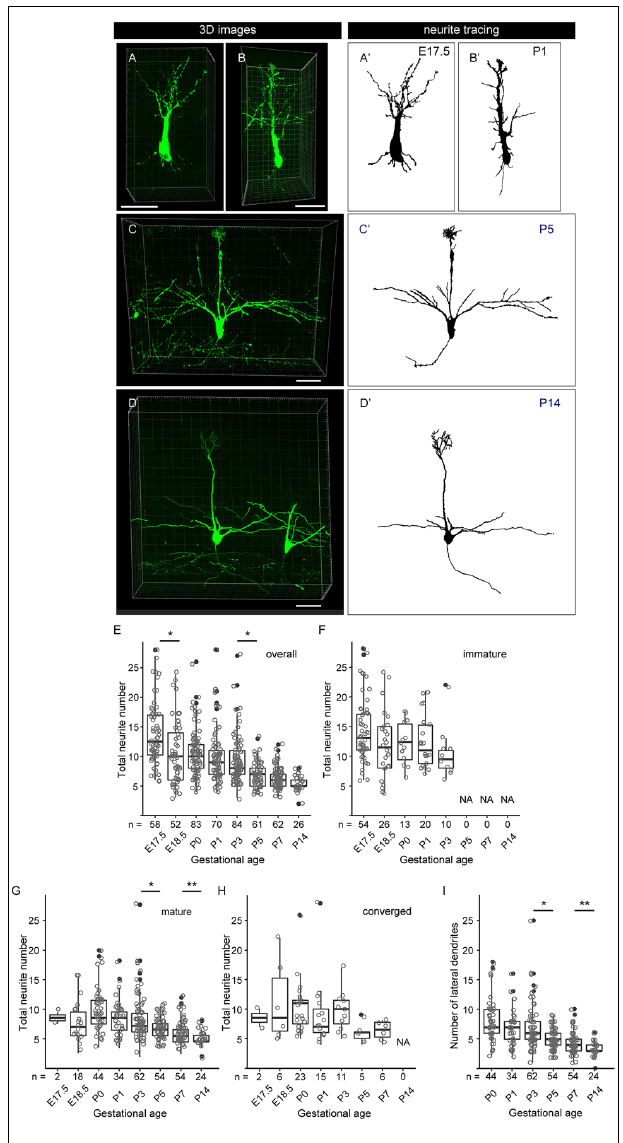
FIGURE 6 | Quantitative analysis of neurite dynamics in developing mitral cells. (A–D) Representative snapshots of three-dimensional reconstructed confocal images of mitral cells and the corresponding traces (A (cid:48) –D (cid:48) ) from each age are shown. Scale bars, 50 µ m. (E) The age-dependent transition of neurite numbers in single mitral cells. The number represents the number of neurites arising from the soma, including both dendrites and axons, of single mitral cells. Statistical analysis was performed with the Kruskal–Wallis test followed by the Steel-Dwass post hoc test for multiple comparisons. Asterisks indicate significant differences (* P < 0.001). (F–H) The age-dependent transition of neurite numbers immature type (F) , mature type (G) , and converged type (H) mitral cells, respectively. Statistical analysis was performed with ANOVA + pair-wise Student’s t -test followed by FDR correction. The significance was accessed between adjacent ages. (I) Changes in age-dependent lateral dendrite numbers. Statistical analysis was performed with the Student’s t -test followed by Benjamini-Hochberg correction. Asterisks indicate significant differences (* P < 0.01, ** P < 0.05). The white dots represent the entire data points, while the black dots represent outliers (outside the range of boxplot whiskers) that automatically come